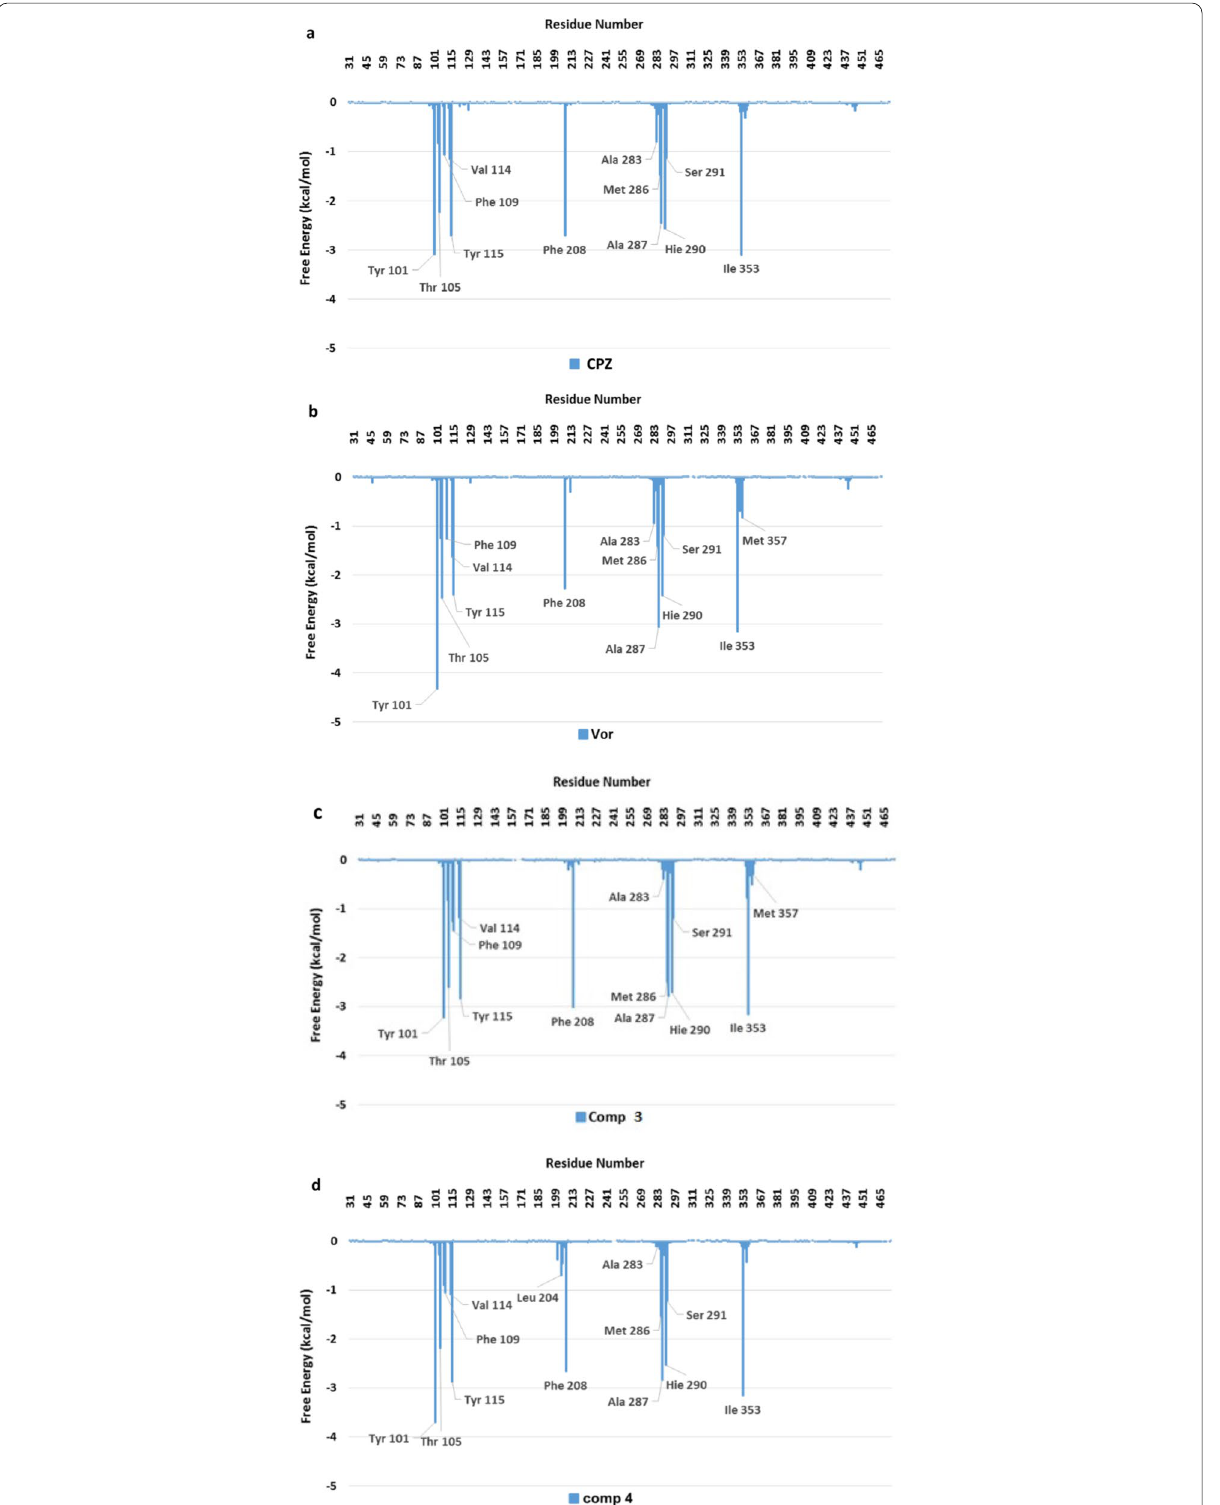
Fig. 6 Histograms of interaction energies partitioned with respect to the amino acids of 14α‑demethylase complexed with compounds: a CPZ, b VOR, c 3 and d 4. The x‑axis denotes the residue number of 14α‑demethylase, and the y‑axis denotes the interaction energy between the compounds and specific residue. Negative values and positive values are favourable or unfavourable to binding,